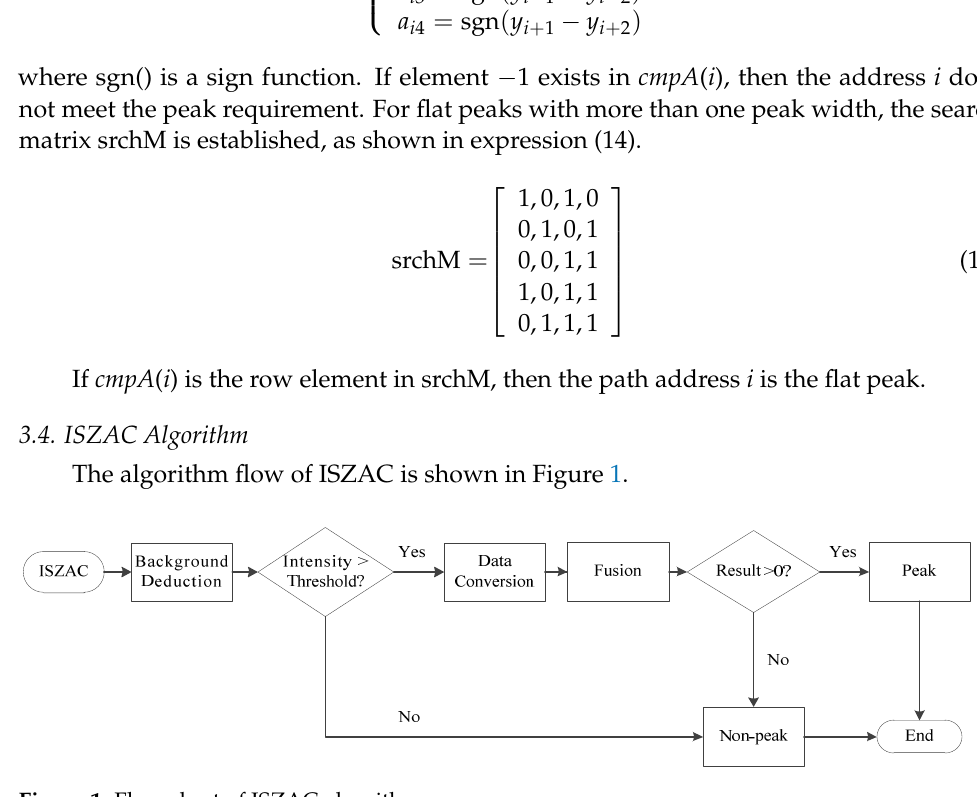
Figure 1. Flow chart of ISZAC algorithm.